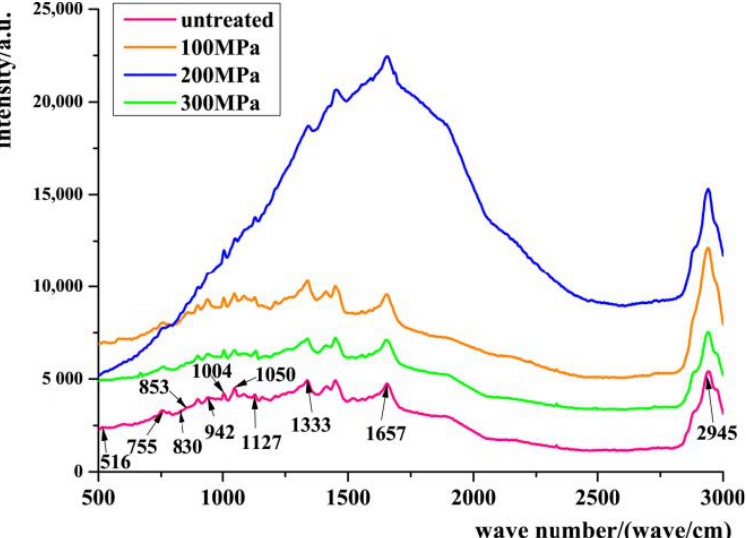
Figure 2. Raman spectra of structural changes of organic materials in adductor muscle under different experimental pressures.